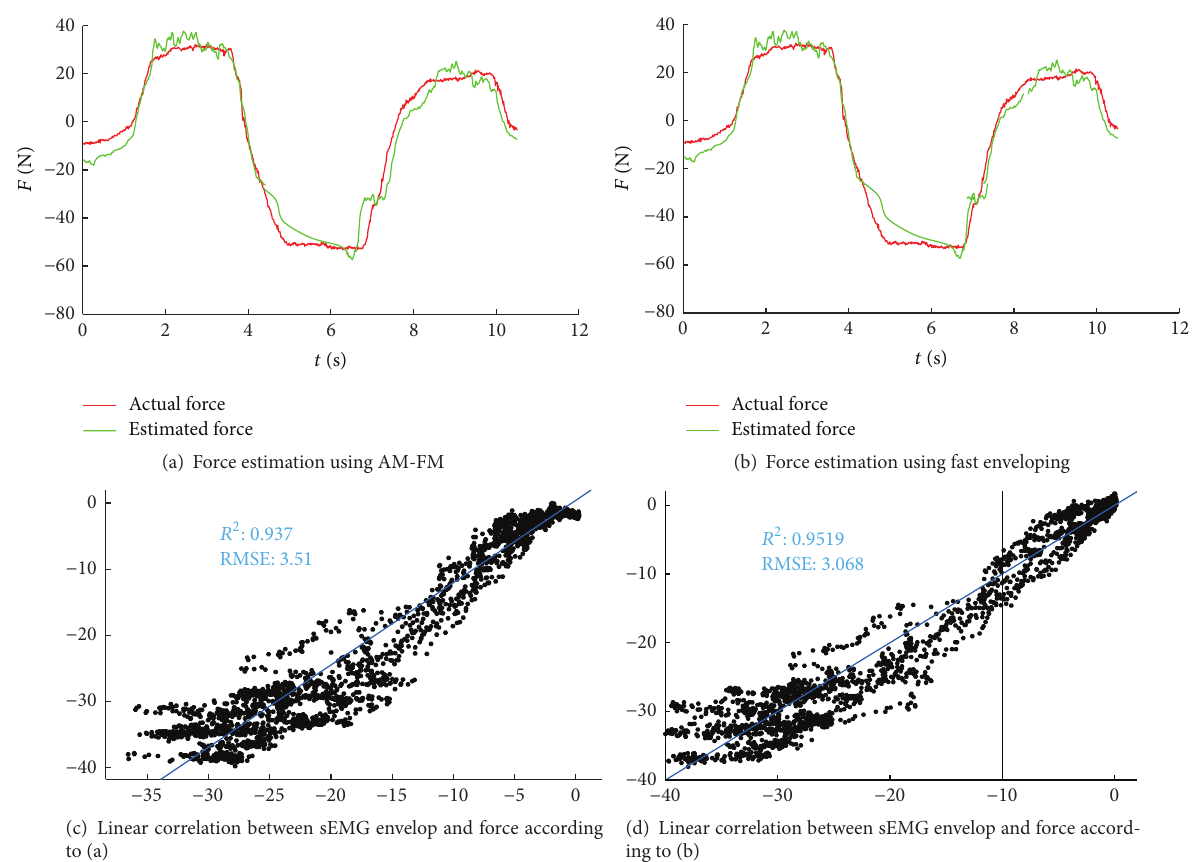
Figure 12: sEMG-force correlation results: raw force signals are processed by low pass filter with 15Hz cutoff frequency. sEMG signals are filtered and smoothed with enveloping using two methods designed in Section 2.